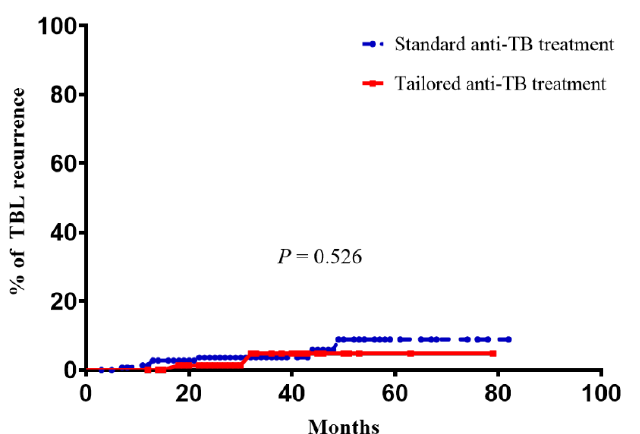
Figure 2. Comparison of recurrence rate between the definitive ( n = 84) and standard ( n = 150) anti-TB therapy groups in patients with TBL who completed anti-TB treatment. TBL, tuberculous lymphadenitis; TB, tuberculosis.